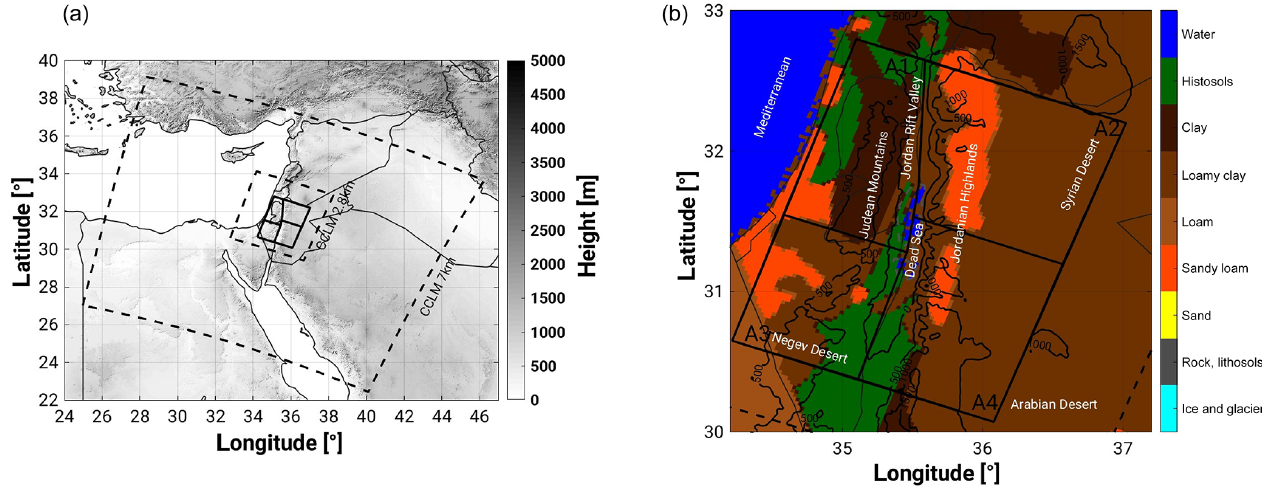
Figure 1. (a) Topography (ma.s.l.), simulation domains (dashed lines, CCLM7km and CCLM2.8km) and study area (bold line). (b) Model soil types (colour scale), topography (black isolines) and study area (bold black line) including the four subdomains being examined, A1–4 (area